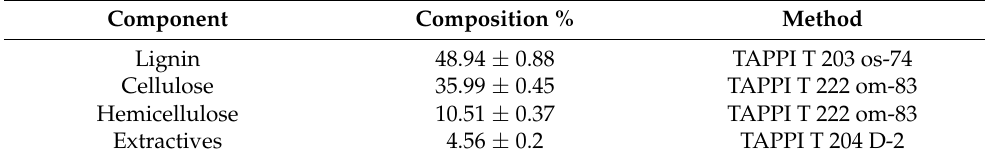
Table 2. Coconut husk bromatological analysis.